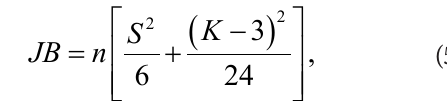
Model 2: In model 2, the skewness is taken as a dependent variable for each index (BSE 500, BSE Sensex, BSE Auto, BSE Bankex, BSE CD, BSE CG, BSE FMCG, BSE HC, BSE IT,